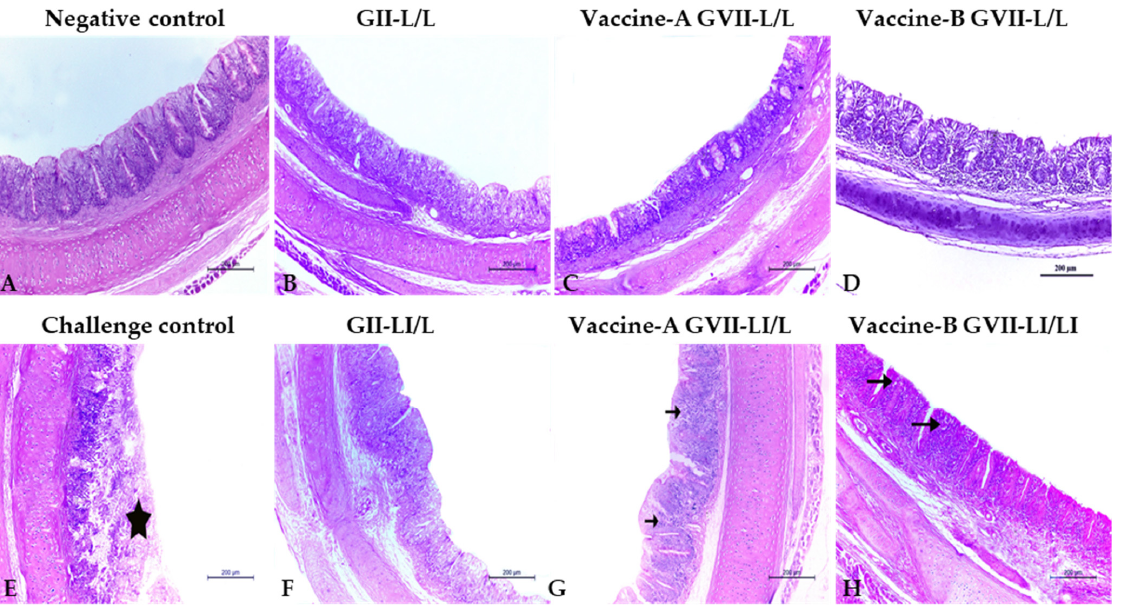
Figure 3. Trachea in vaccinated and control groups chicks at 7 days post challenge (H & E stain, ×100), showing the normal histopathological architecture of trachea with few lymphocytes in the submucosa and between mucosal epithelium in the negative control group (arrows) ( A ). The challenge control group showed severe deterioration of the tracheal structure and tracheal casts (star) ( E ). All vaccinated groups ( B , D , G , H ) had reduced tracheal mucosa damage, except for the vaccine-B GVII L/L ( C ) and the LaSota GII LI \ L ( F ) groups. Abbreviations: GII: genotype II-based vaccine, GVII: genotype VII.1.1.-based vaccine, L/L: live vaccine at 7 and 21 days, LI/L: live and inactivated at 7 days, then live vaccine at 21